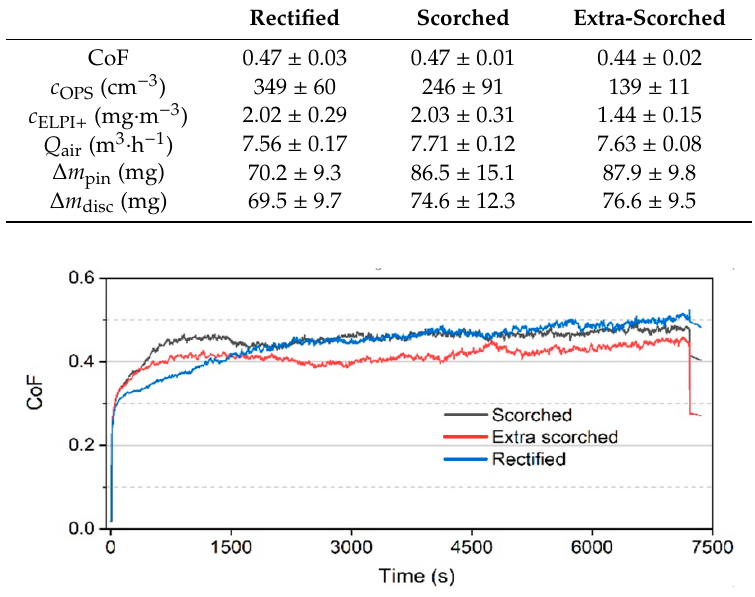
Figure 5. Representative measured coefficient of friction curves for the three surface types.